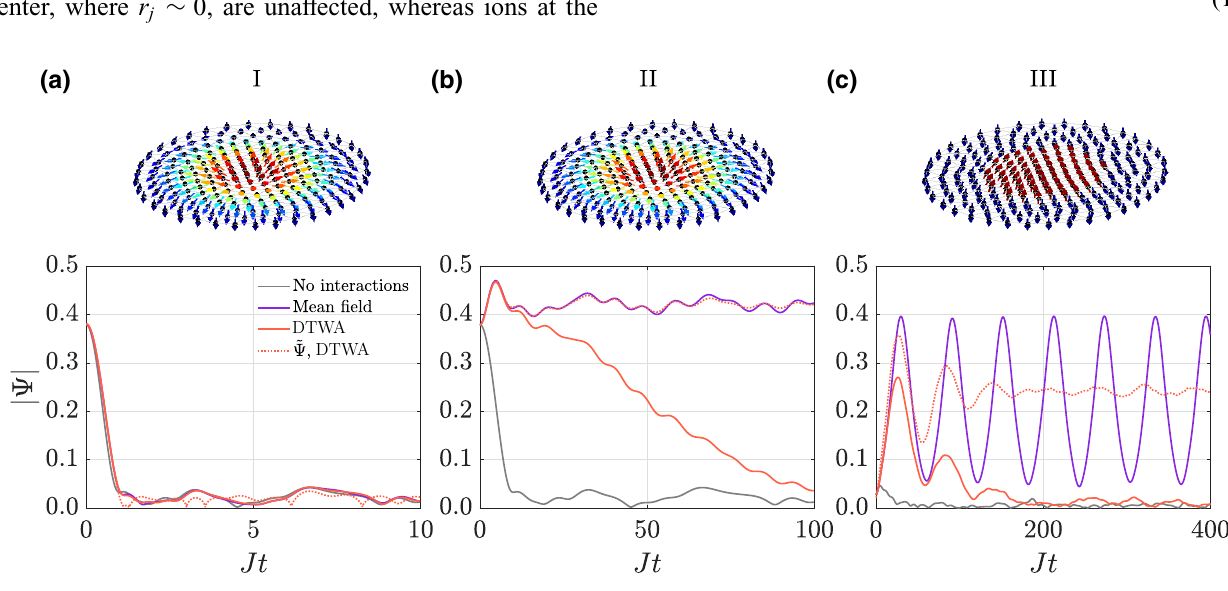
FIG. 2. Manifestation of dynamical phases in a 200 ion crystal. Initial BCS-like spin textures (top panels) and time evolution of | (cid:5)( t ) | in phases (a) I, (b) II, and (c) III. In (a) K / J = 10, while in (b) and (c) K / J = 1. The dynamics of | (cid:5)( t ) | are computed both using mean-field theory and the discrete truncated Wigner approximation (DTWA) method. The DTWA results show that the finite size of the crystal leads to a decay of | (cid:5)( t ) | even in phases II and III. However, the buildup of quantum correlations in these phases is captured by a second order parameter ˜ (cid:5) [Eq. (20)]. In all cases, the decay of | (cid:5)( t ) | in the absence of interactions is plotted for reference. Crystal parameters are detailed in Appendix B and chiral spin states are initialized according to Appendix